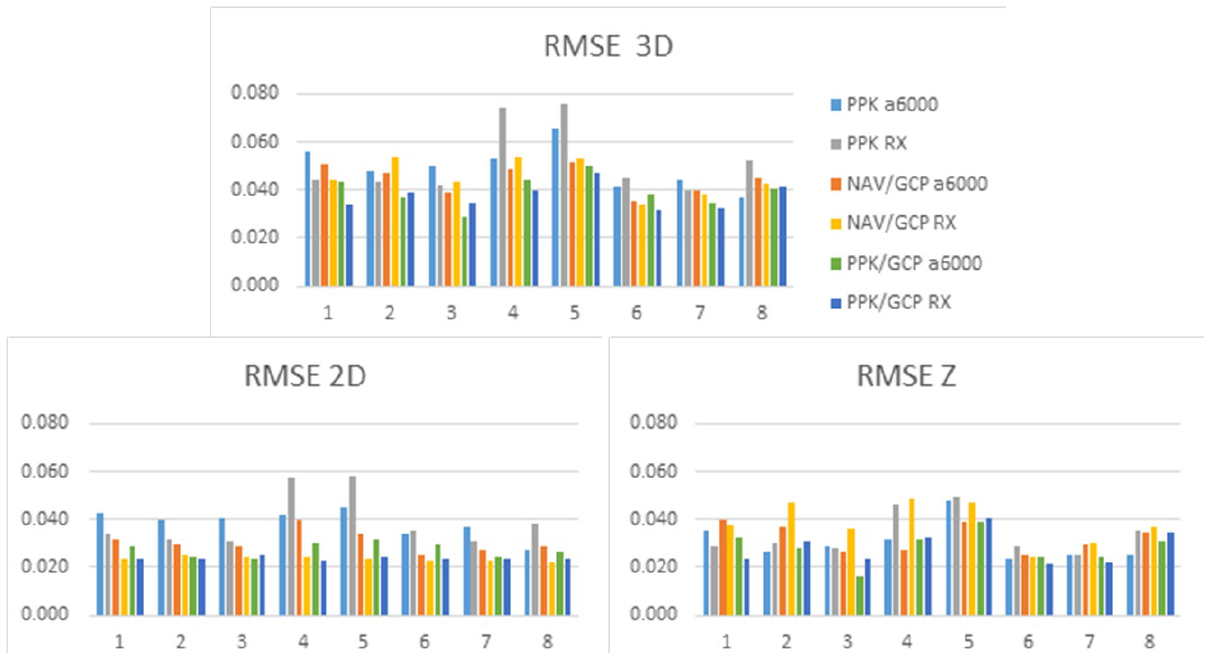
Figure 5 RMSE values at Check points (Group I) calculated in